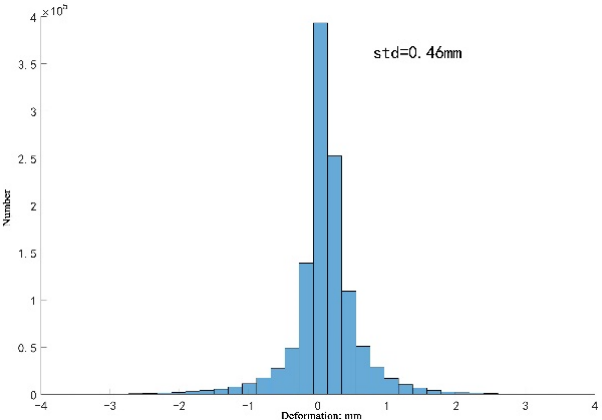
Figure 13. 10/30 00:09 Residual plot of real and predicted values.